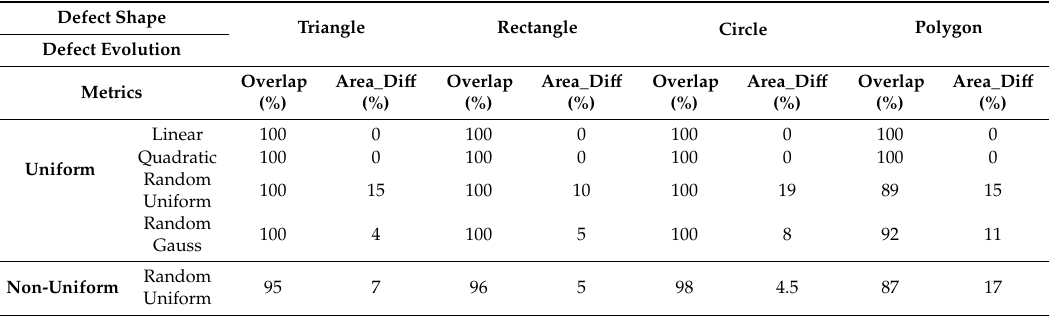
Table 2. Comparison of predicted defect shape using autoregressive integrated moving average (ARIMA) model against ground truth.